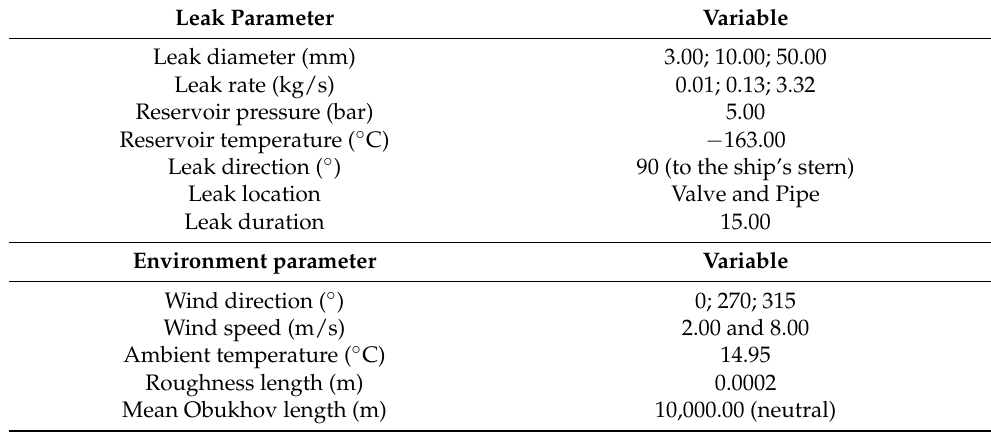
Table 4. Summary of the leakage scenario.